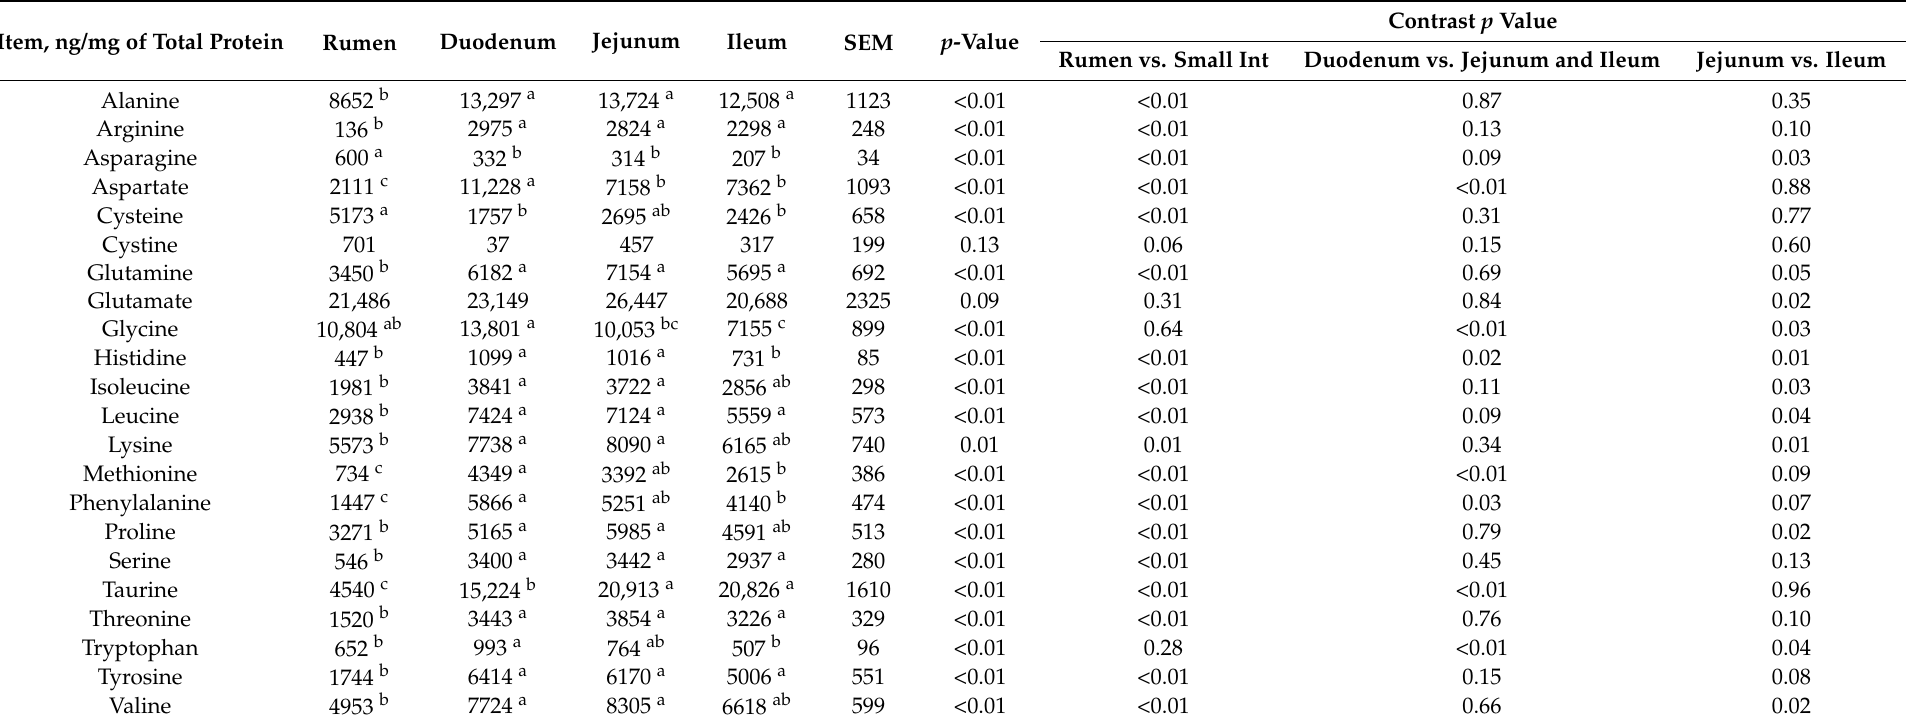
Table 1. Least-squares means, pooled SEM, and p -values for amino acid concentrations in tissue harvested from the rumen, duodenum, jejunum, and ileum from lactating Holstein cows ( n =